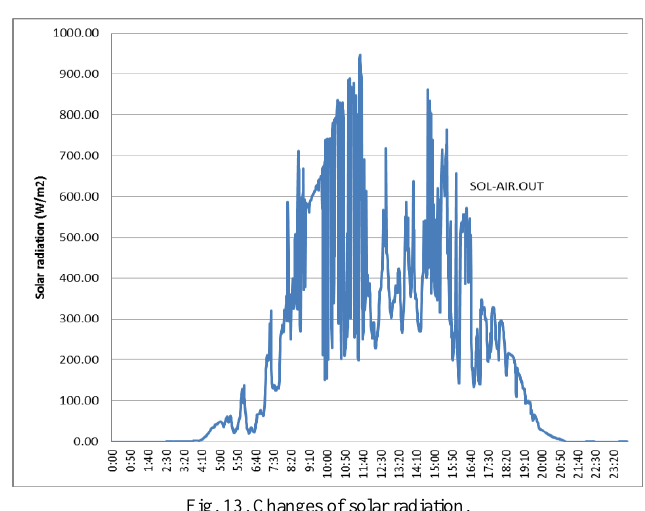
Fig. 13. Changes of solar radiation.